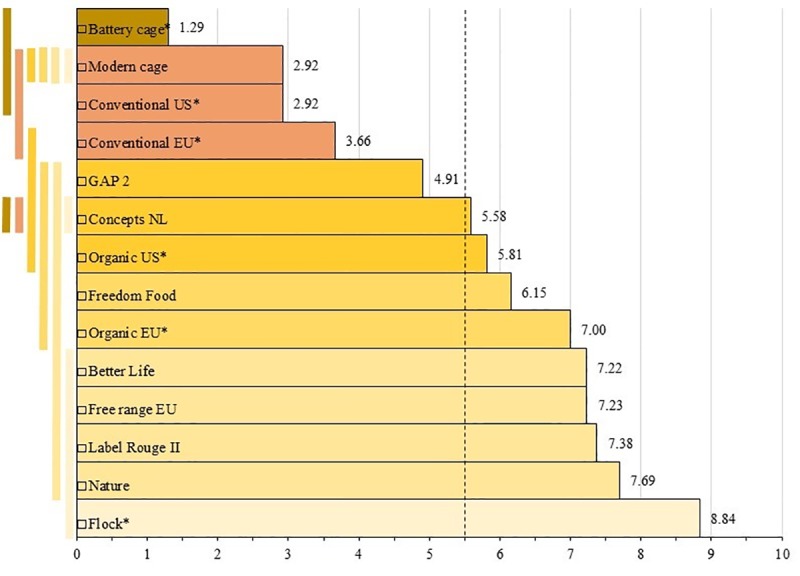
Significant differences between means of given welfare scores (GWS) of housing systems (HSs) based on the REML analysis.HSs with differently coloured vertical bars differ significantly (p< = 0.05). The dotted line indicates the cut-off for acceptability (5.5, in accordance with common usage on this scale, see the discussion); *: Preferred for assessment.